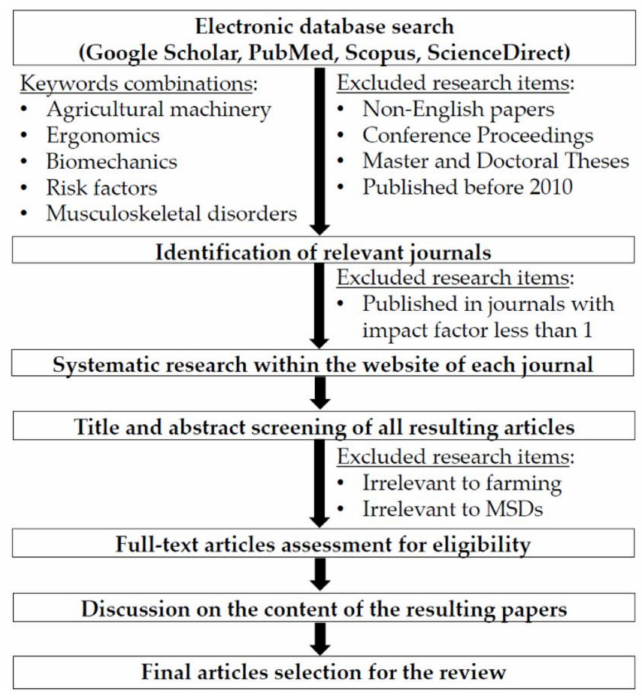
Figure 2. Flowchart of the present survey